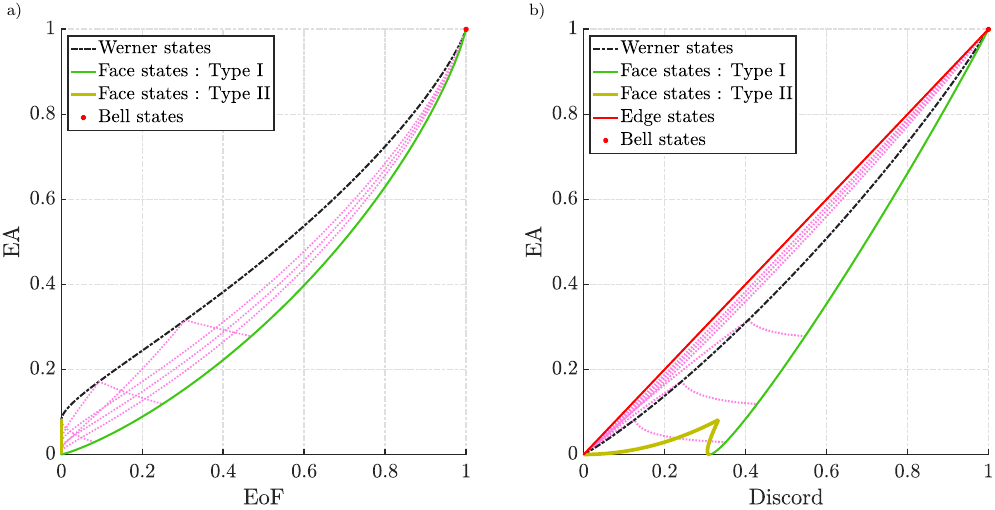
Figure 7. Comparison of EA with EoF and discord for Bell-diagonal states. The dashed pink lines correspond to the rank 4 Bell-diagonal states depicted in Fig. 6d.